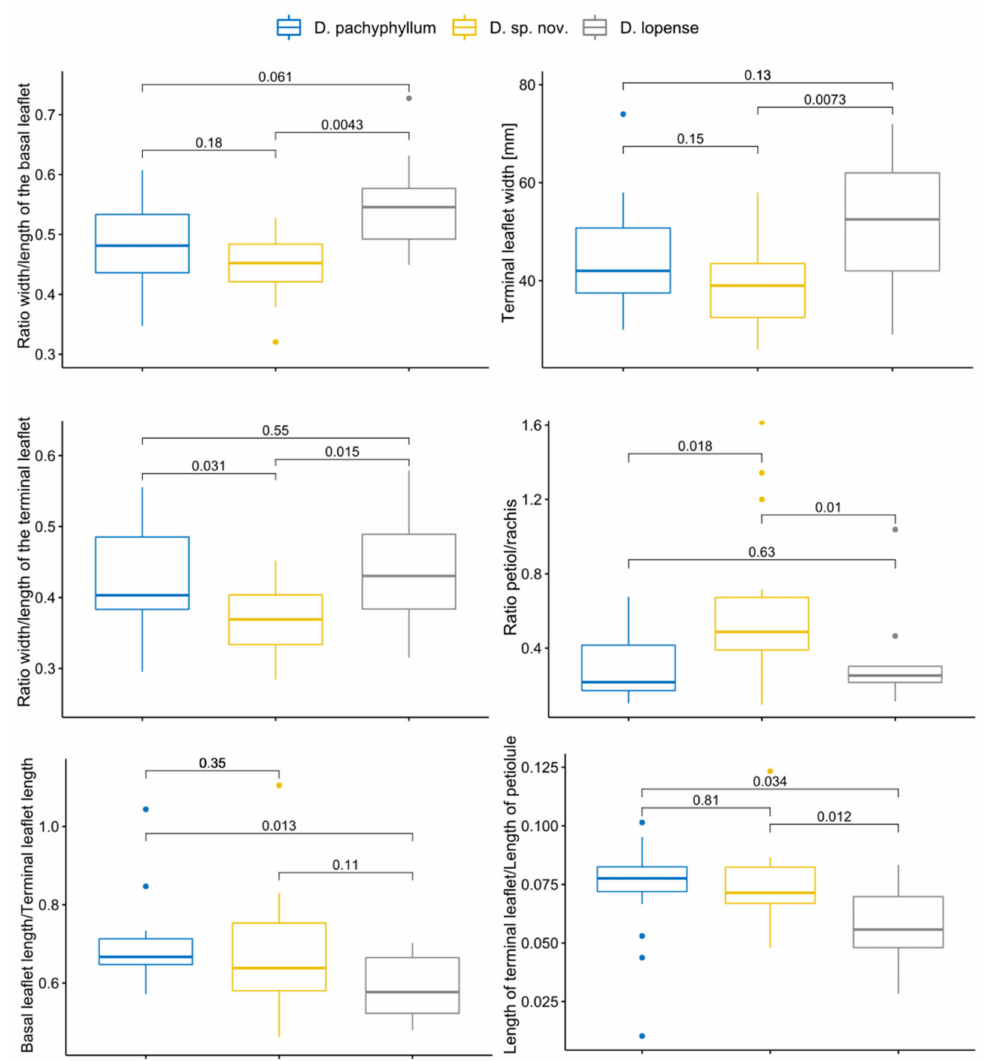
Figure 3. Significant leaf morphological trait variations between Dialium pachyphyllum , Dialium sp. nov., and Dialium lopense . p -values for species comparison are related to t -tests (ra- tio w / l of the basal leaflet, terminal leaflet width, ratio length of terminal leaflet/length of petiolule) and Wilcoxon tests (ratio petiol/rachis, ratio basal leaflet length/terminal leaflet